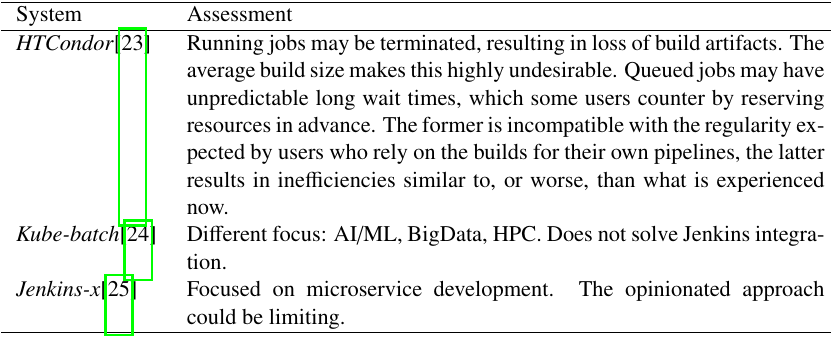
the approaches presented so